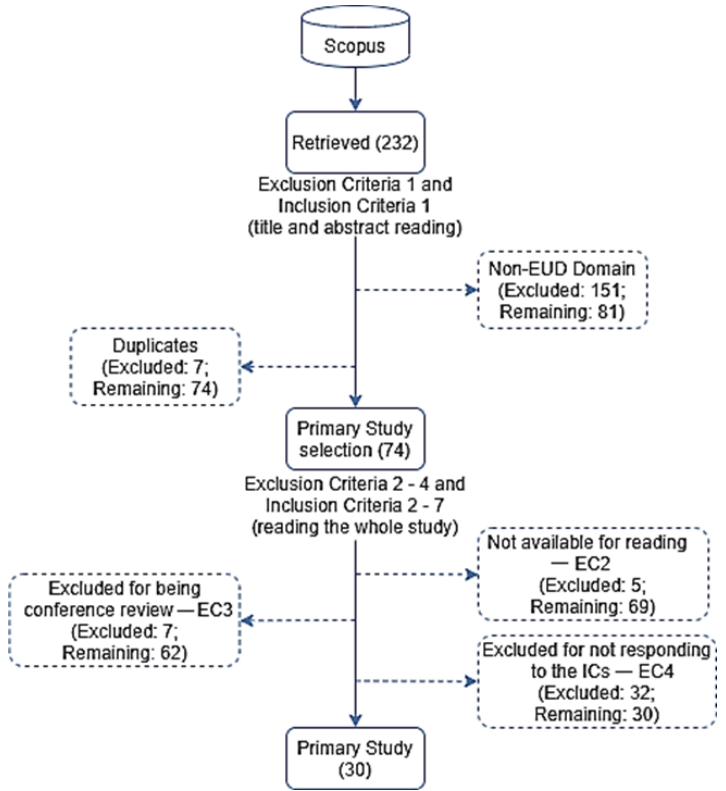
Figure 2. Process of paper